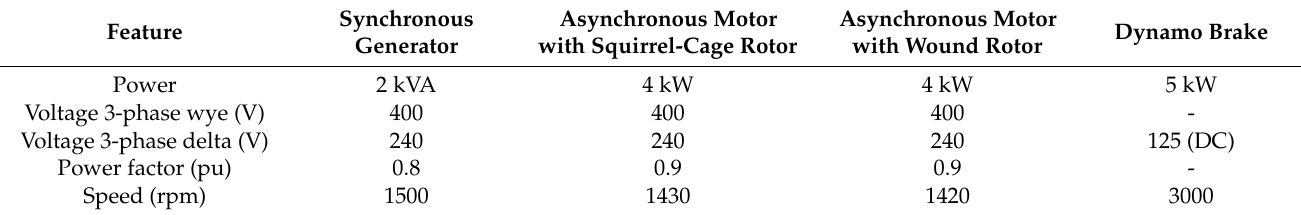
Table 7. Features of the electrical machines.